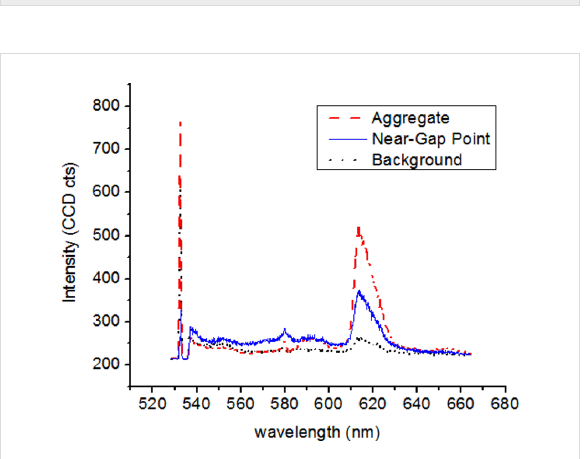
Figure 17: Fluorescent intensity obtained by confocal microscopy of spin-coated nanoantenna structures under excitation with 532 nm radi-